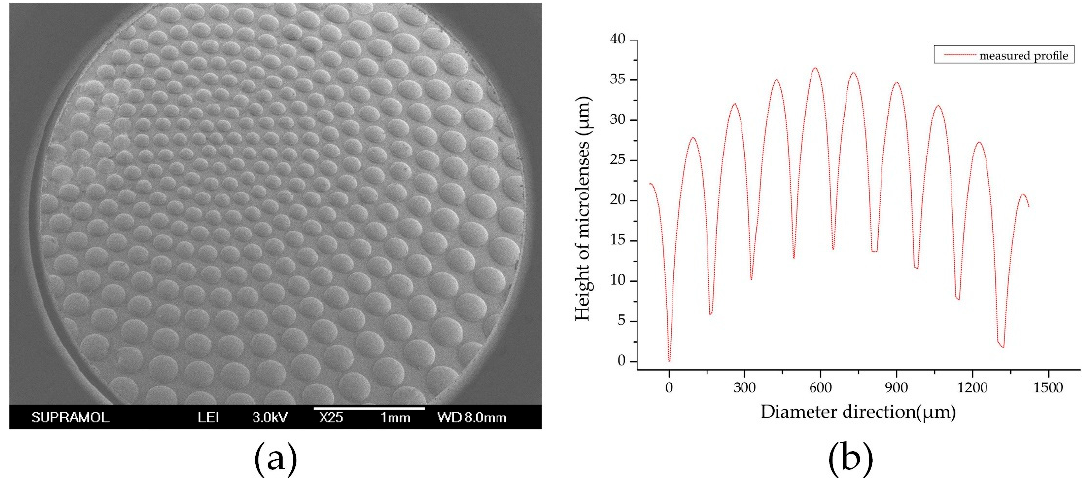
Figure 6. Three-dimensional (3D) profile of the compound eye: ( a ) SEMimage of the multifocal compound eye at side view; ( b ) the measured profile of microlenses in center of the multifocal compound eye.